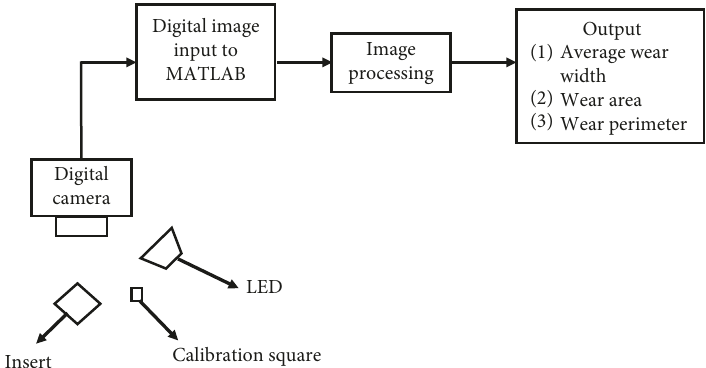
Figure 1: Schematic diagram of the tool wear measurement system.